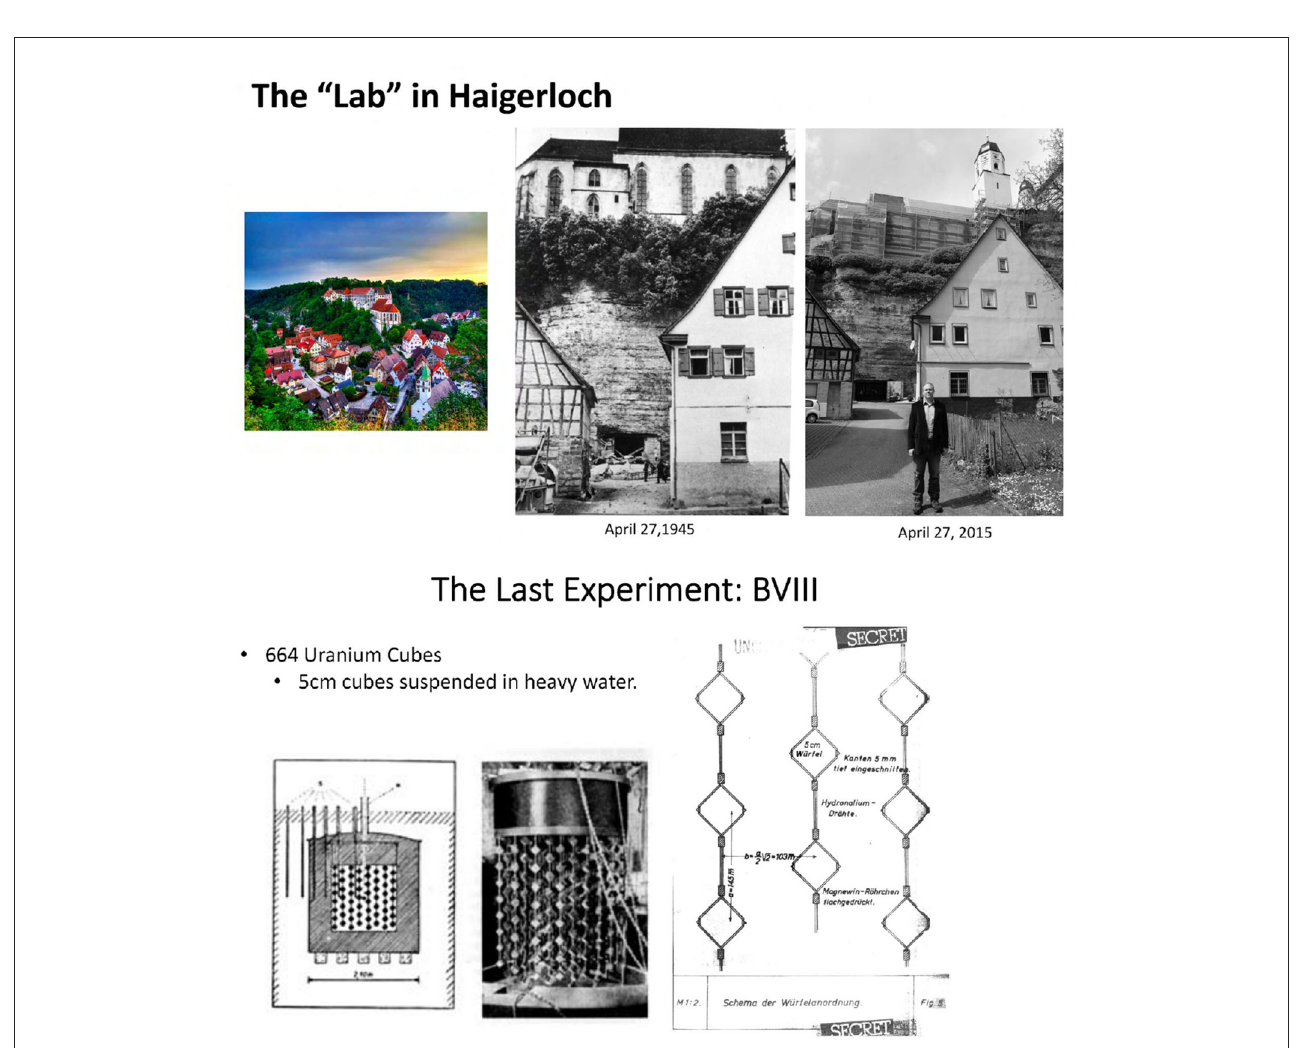
FIGURE13 Slides depicting Nazi Uranprojekt laboratory led by Heisenberg in Haigerloch and experimental setup of the BVII reactor. Lecture